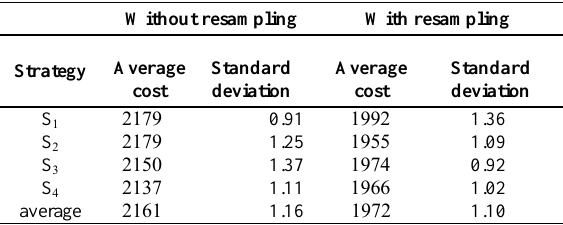
Table 6. Results of proposed methodology (without cost sensitive learning).